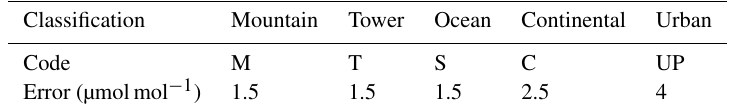
Table 1. Representation error of station locations.